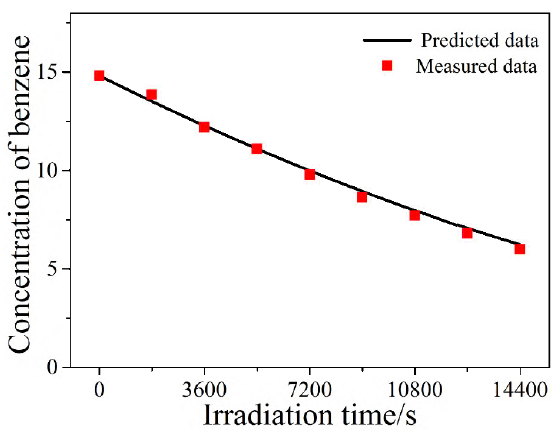
Figure 6. The predicted and measured concentration of benzene vs. time.